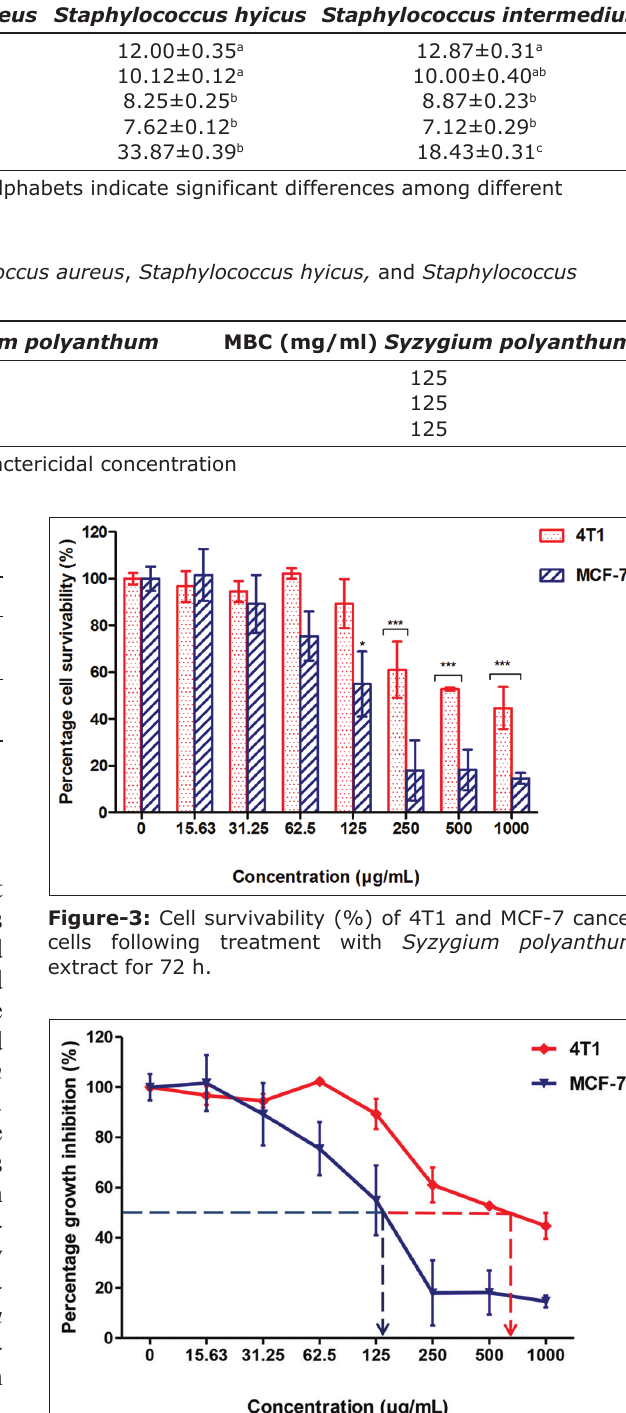
Table-4: Mean diameter zone of inhibition produced by hydromethanolic extract of Syzygium polyanthum against respective bacteria. Plant extract